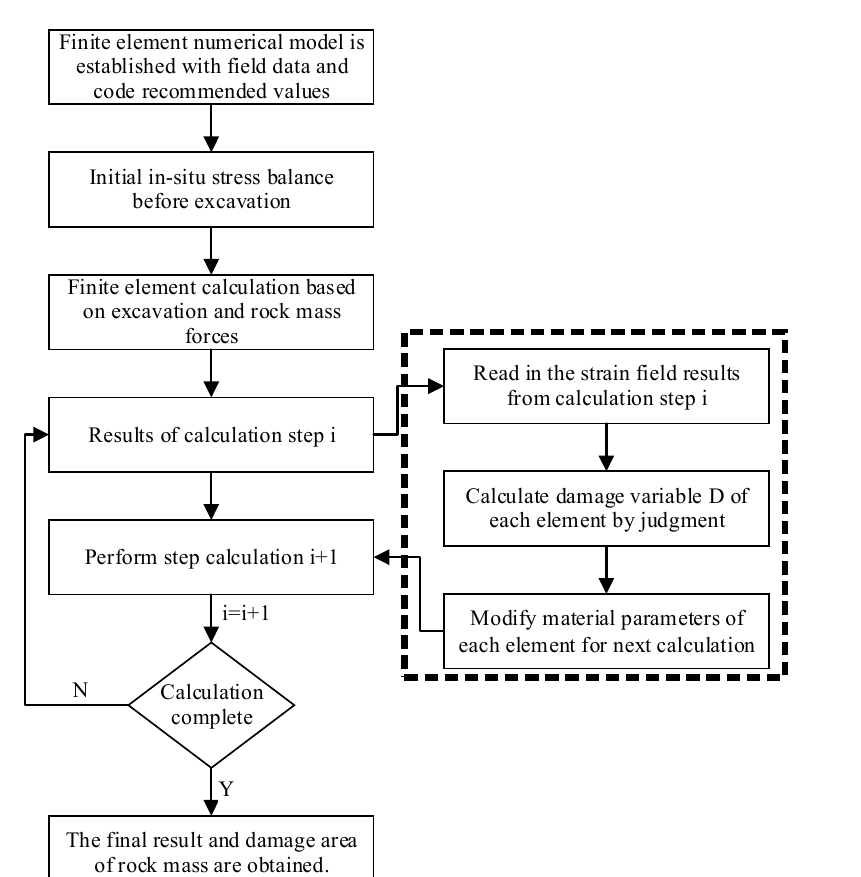
Figure 11. Simulation process based on the dual softening damage effects.